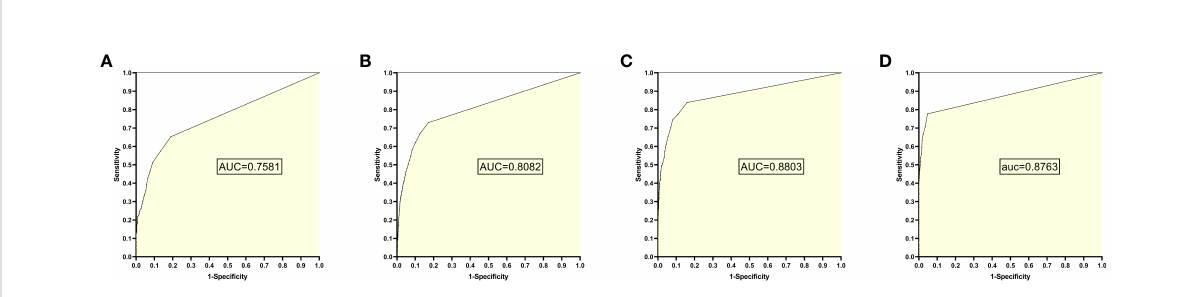
FIGURE 8 ROC curves and AUC values obtained from the training set 7 model testing each test set: (A) results from test set 1; (B) results from test set 2; (C) results from test set 3; (D) results from test set